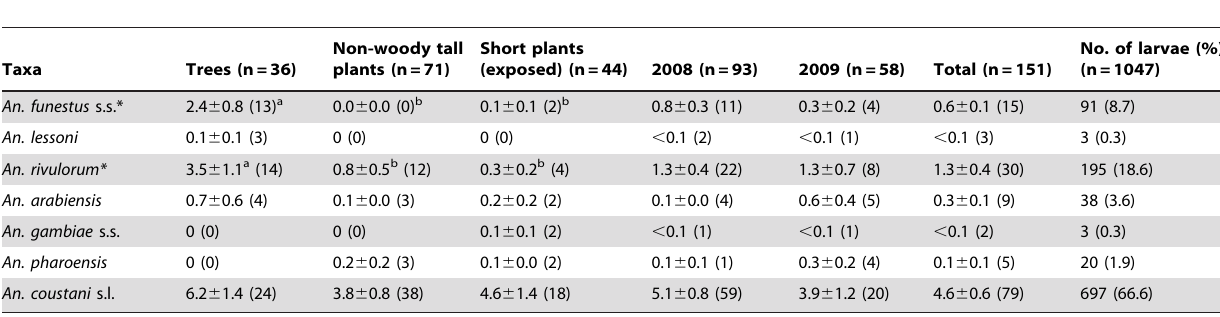
Table 1. Mean densities 6 SE (per site) and occurrences of anopheline larvae sampled from the water hyacinths that were surrounded by trees or other tall emergent plants, or that were exposed to waves in the lake in 2008 and 2009.